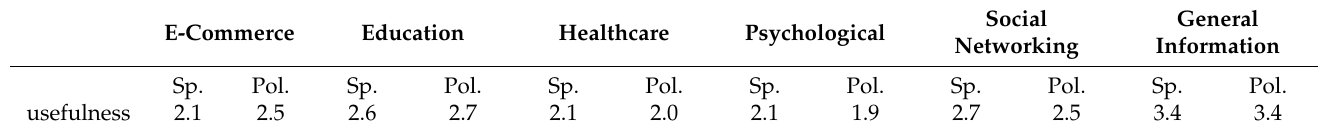
Table 3. Perceived usefulness of chatbots (five-point scale: from 1 = not useful at all to 5 = very